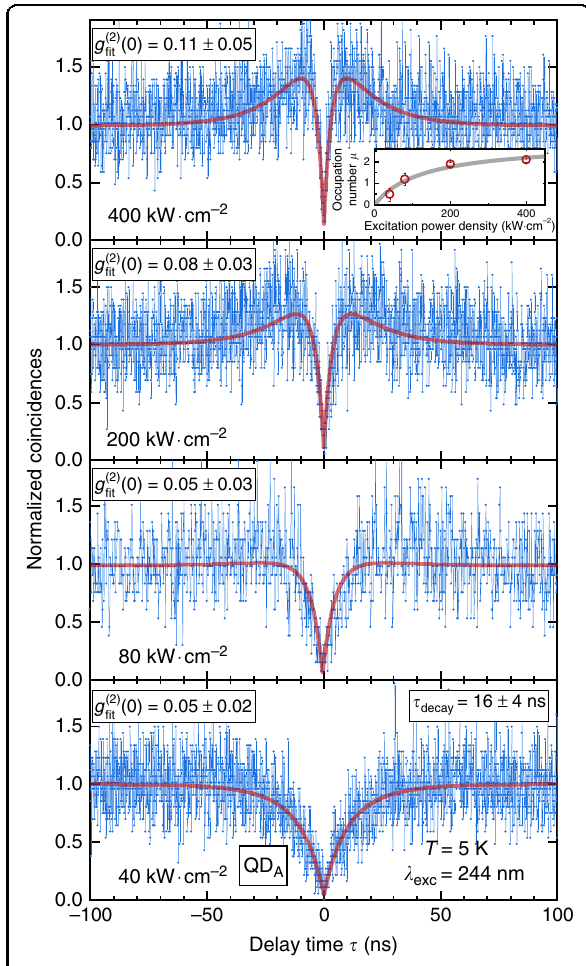
Fig. 3 g (2) ( τ ) traces of QD A recorded at 5 K as a function of excitation power density (connected blue diamonds) and convoluted fi ts (red lines). The channel resolution is fi xed to 100 ps/ channel at 40, 200 and 400 kW cm − 2 . Given the smaller number of total coincidences measured at 80 kW cm − 2 , the corresponding data are shown with a 200 ps/channel resolution. The exciton decay time being in theory power-independent, its value is extracted by fi tting all traces with a shared τ decay value. The inset shows the evolution of the fi tting parameter µ upon increasing power. The data (red circles) are fi tted using Eq. 2 (grey line,) which yields µ = 2.9. All uncertainties sat are obtained in the simpli fi ed framework described in the text and indicate the robustness of the fi t. The full collected data span a